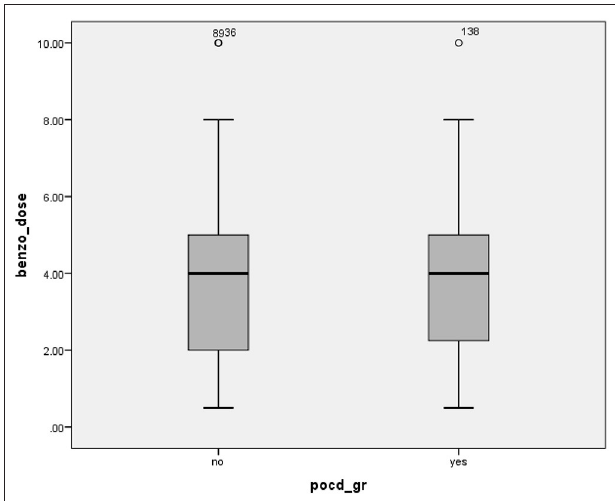
FIGURE 3 | Median (IQR) dosage of intraoperative benzodiazepine compared between the non-POCD and POCD groups ( p > 0.05). IQR, interquartile range; POCD, postoperative cognitive disorder.